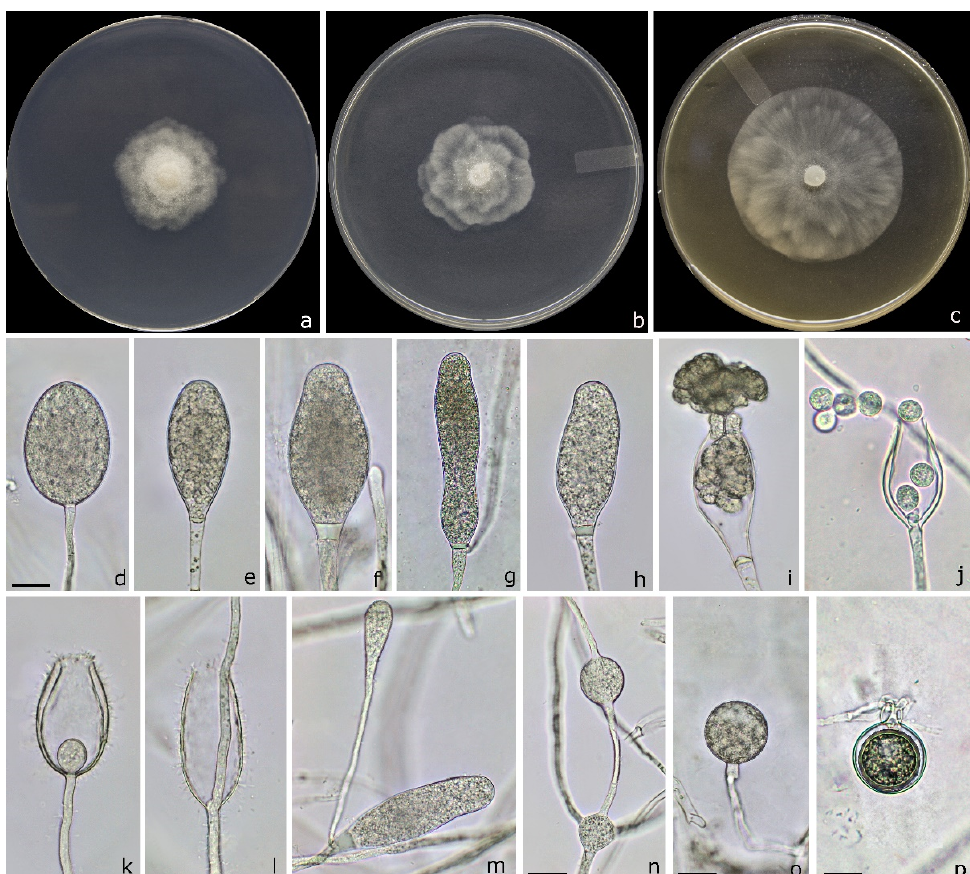
Figure 4. Colony morphology of Phytophthora marrasii (CB150) after 7 days growth at 25 °C on PDA ( a ), MEA ( b ), and CA ( c ). Non-papillate and persistent sporangia ( d – h ), release of zoospores ( i , j ), internal ( k , l ) and external ( m ) proliferations, intercalary hyphal swellings ( n ), and a terminal chlamydospore ( o ). Oogonium with an amphygynous antheridium ( p ). Scale bars = 20 µm.